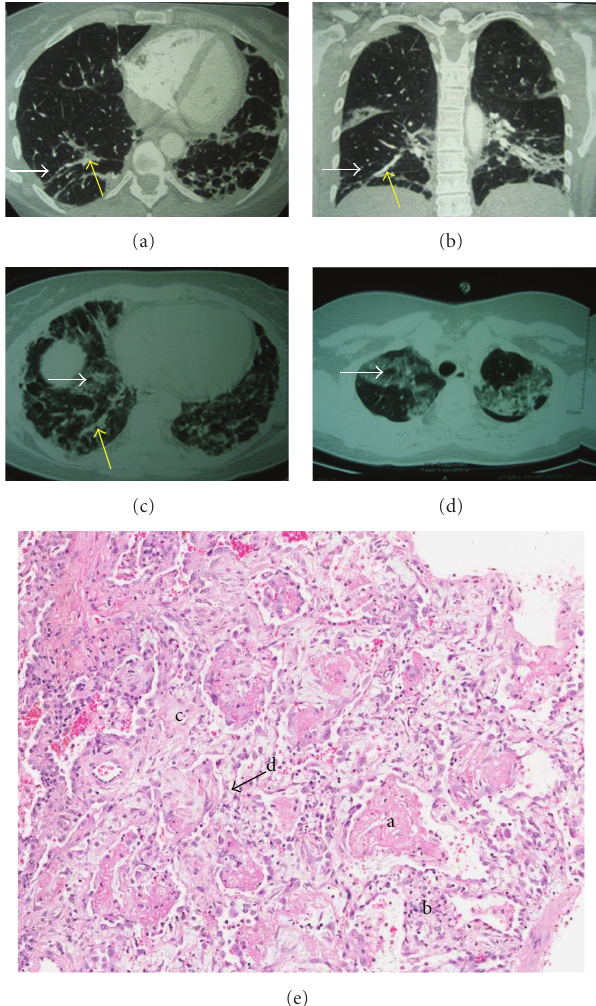
Figure 1: (a) and (b) CT findings of “focal areas of lung parenchymal infiltrates with ground-glass opacities, associated (white arrow) with septal thickening (yellow arrow), with peripheral distribution.” (c) and (d) CT findings of interstitial infiltrate, with di ff use ground glass opacity with foci of parenchymal densification (yellow arrow) and some air bronchograms (white arrow). (e) Histhopatological examination showing (1) intra-alveolar accumulation of fibrin in the form of solid blocks; (2) acute inflammatory infiltrate in the interstitium; (3) alveolar septal edema and congestion; (4) xantomatososum macrophages